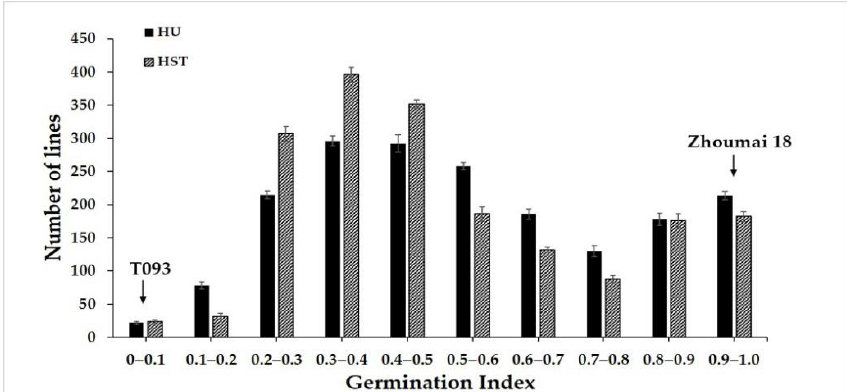
Figure 1. Frequency distributions of the germination index values of the F 2 population of wheat tested at two field sites. HU denotes Henan University; HST denotes the Henan Agriculture High- Technology Science and Technology Park.